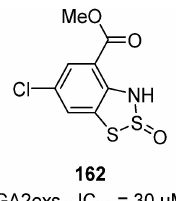
Figure 40. GA2oxs inhibitor methyl 6-chloro-3 H -benzo[ d ][1,2,3]dithiazole-4-carboxylate 2-oxide ( 162